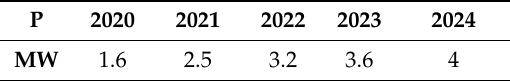
Table 7. The evolution of